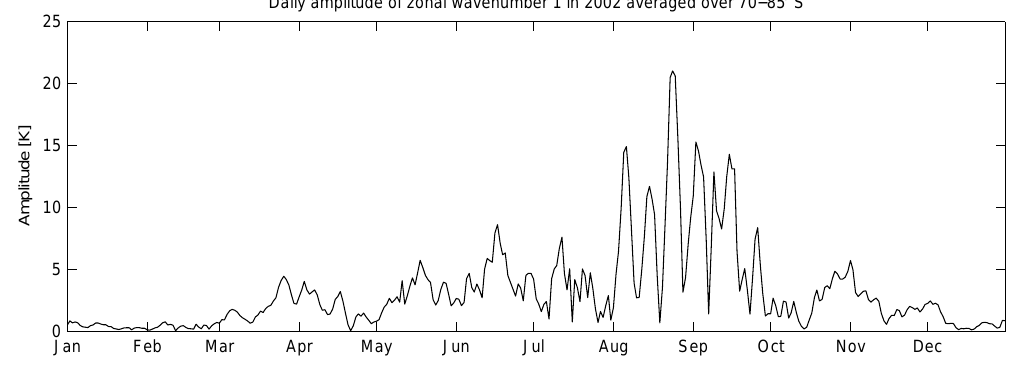
Fig. 8. Daily amplitudes of zonal waveumber 1 (Z1) computed form NCEP temperatures averaged over the latitudes between 70 ◦ S and 85 ◦ S and at the 10hPa